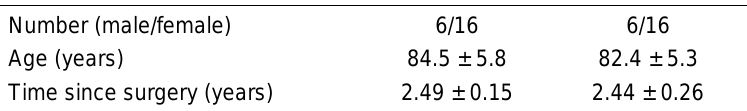
Subject Characteristics of Patients Included in the 2-Year Follow-Up and Causes for Unavailability for Follow-Up Patients at 2-Year Follow-Up